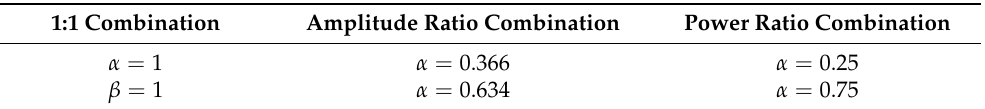
Table 2. L1C/B1C signal combination coefficient.